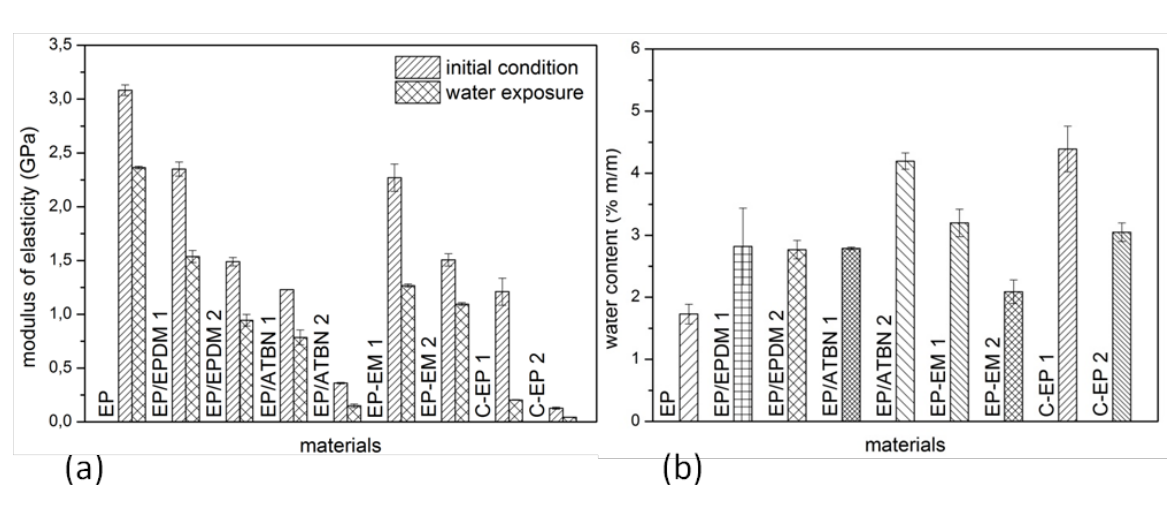
Figure 3. ( a ) Modulus of the initial condition (fully cured) and after water exposure for 28 days at 40 °C, dynamic mechanical analyses (DMA); ( b ) Water content of the materials after 28 days at 40 °C, investigated by thermogravimetric analysis (TGA).